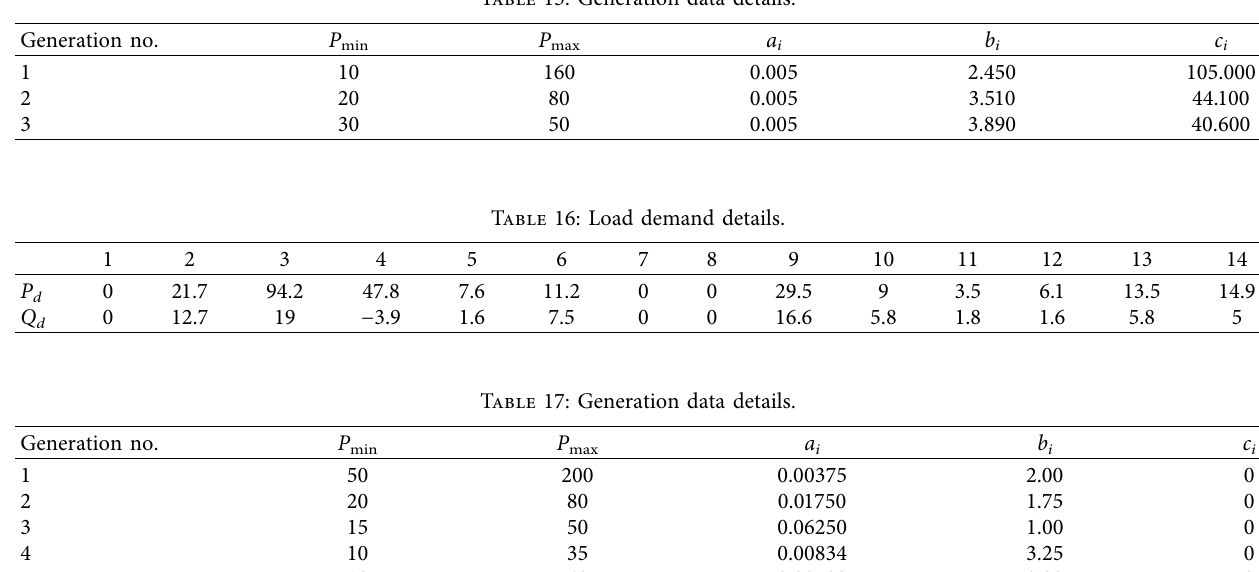
Table 15: Generation data details.